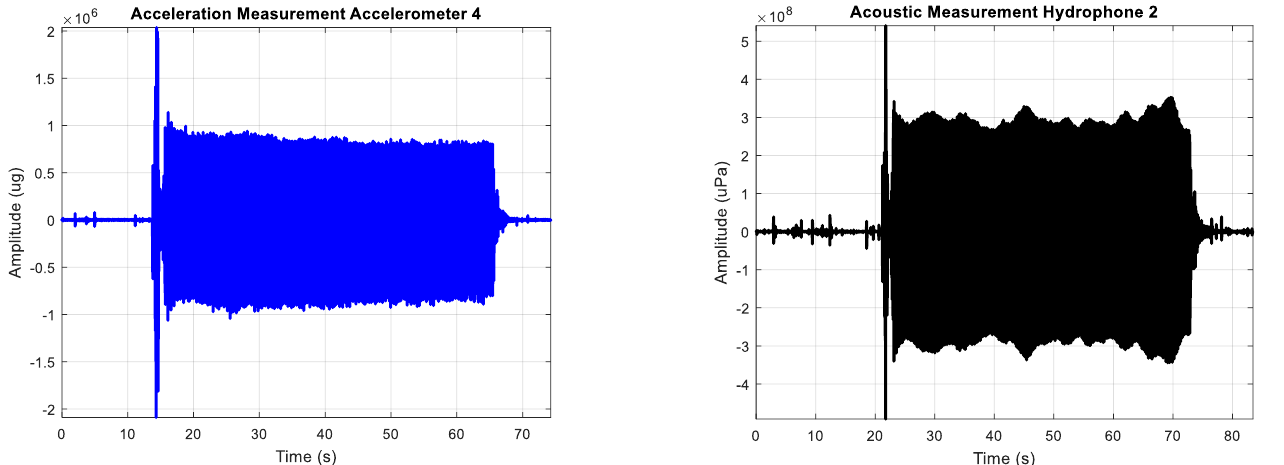
Figure 5. Typical time series of the measurement of the vibration of the hull in µg ( left ) and under- water radiated noise in µPa ( right ) with the main engine started.